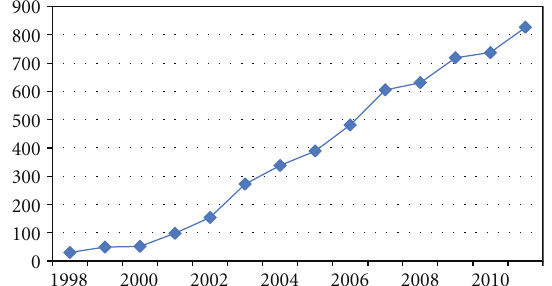
Figure 1: 1998–2011 CNKI related to “teacher evaluation” of the literature quantity change